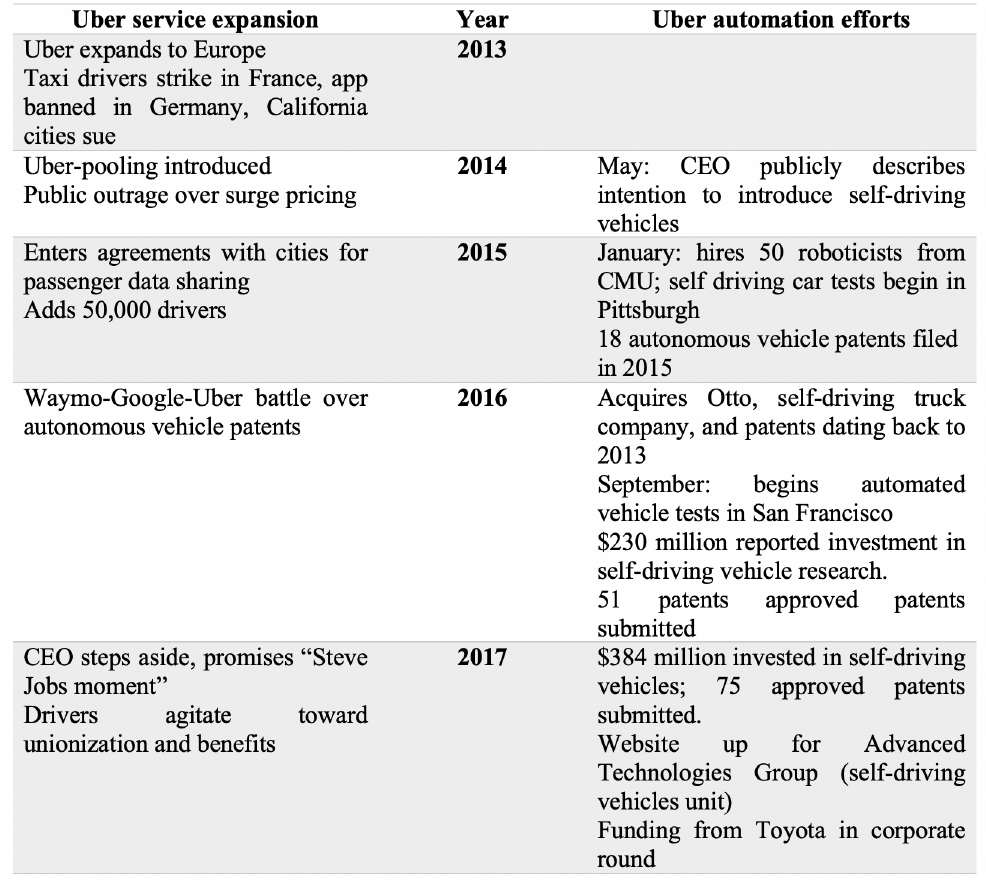
Figure 5: Parallel timelines for Uber service roll-out alongside car automation efforts. Sources: LexisNexis, US Patent Database, Crunchbase.com, Uber Technologies Inc. S-1 Registration